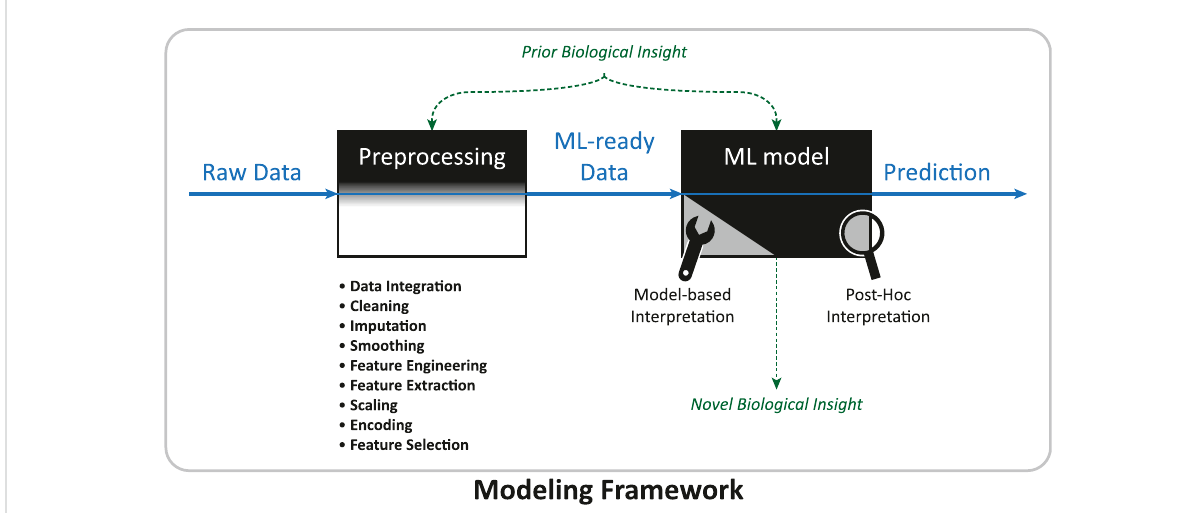
FIGURE 2 Data and information fl ow in a modeling framework. The modeling framework inhabits the complete work- fl ow of a machine learning project, fromtherawdatasettoproducinga fi nalprediction.Datapreprocessingconvertstherawdatasetintoadatasetsuitableformachinelearning.Inthe machinelearningphase,model-basedorpost-hocinterpretationmethodsmightbeappliedtogeneratenovelbiologicalknowledge.Priorbiological insight (see Table 2 for examples) might enter at different steps, sometimes improving the interpretability of the ML